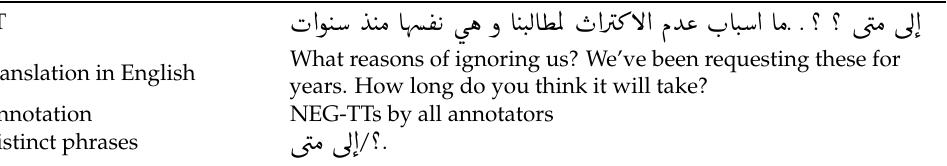
Table 14. TT including an